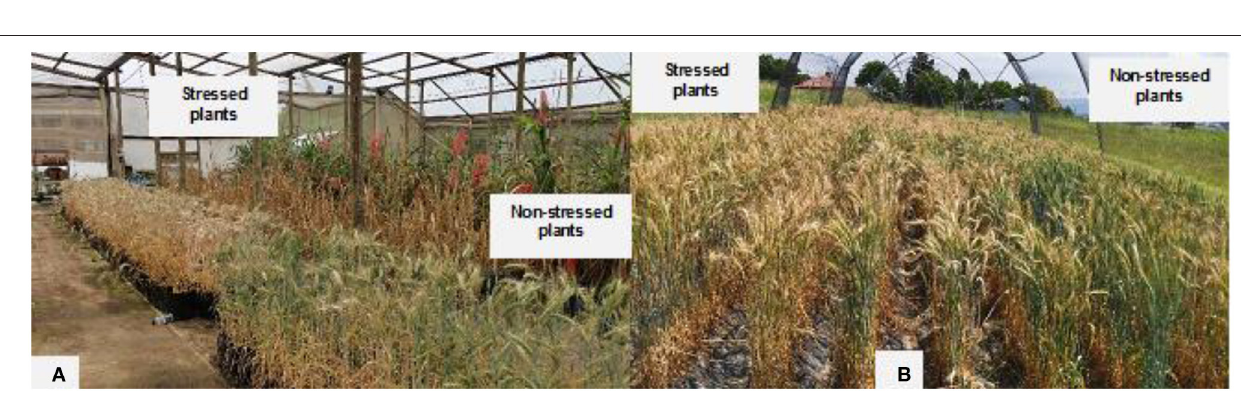
potential and enhance grain threshability (Sharma et al.,